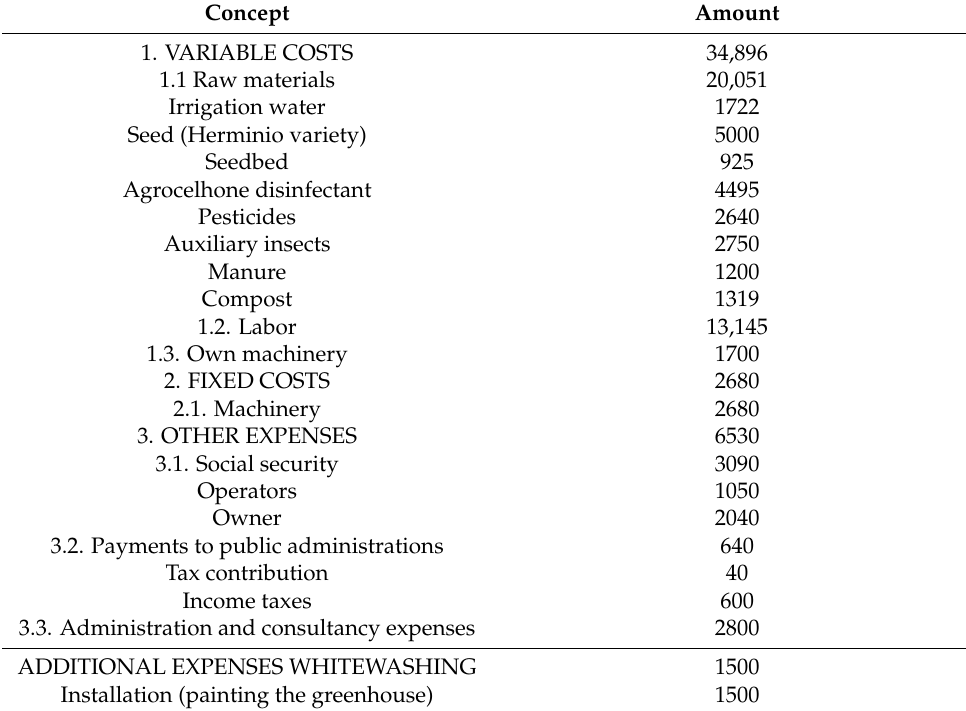
Table 8. Summary of annual